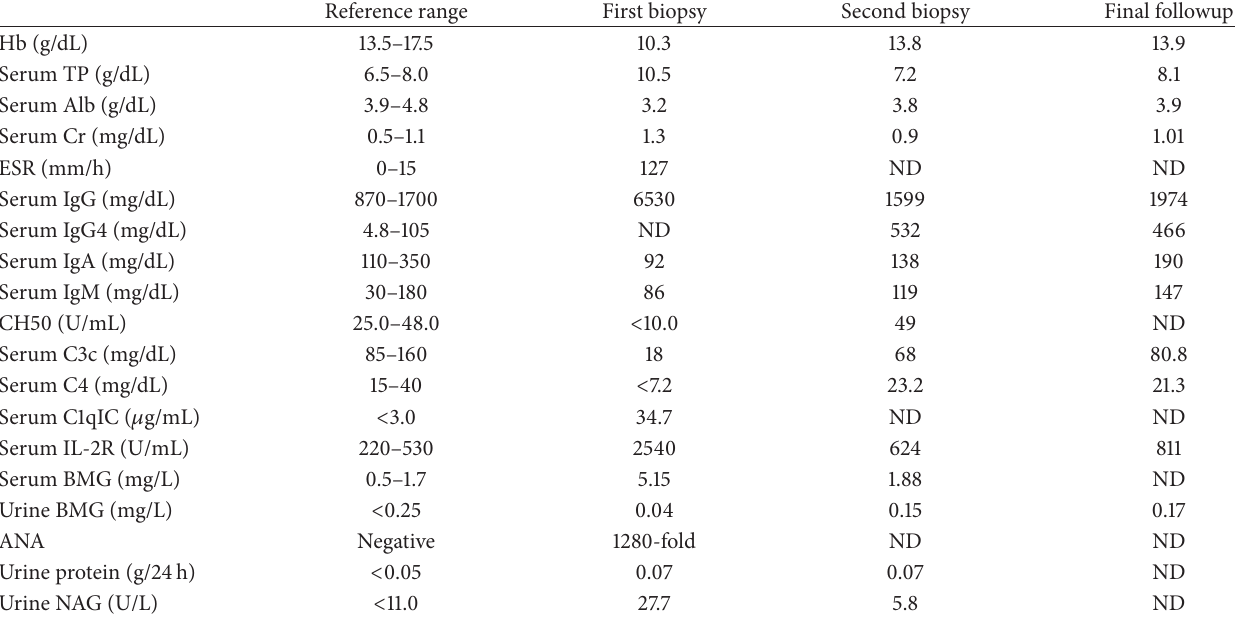
Table 1: Clinical parameters at the first and second renal biopsy and at the final